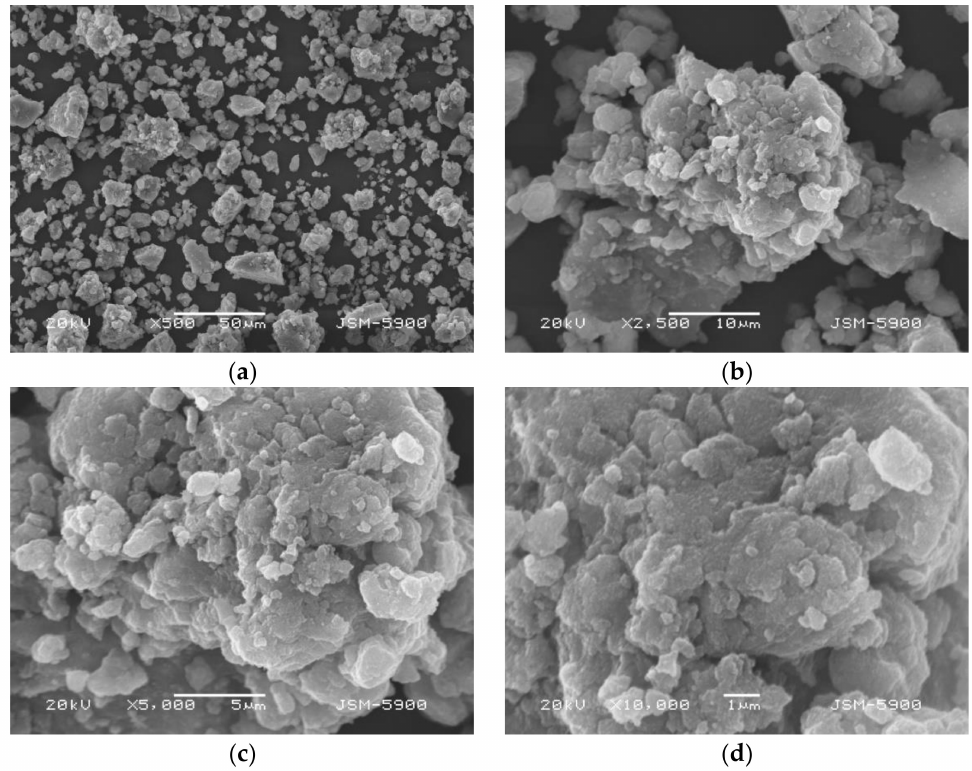
Figure 1. Micrographs captured by SEM at various magnifications (( a ) × 500, ( b ) × 2,500, ( c ) × 5000, and ( d ) × 10,000) of Mg-5Ni dehydrogenated at the eighth cycle. An X-ray diffractogram of Mg-5Ni dehydrogenated at the eighth cycle is shown in Figure 2. The sample contains Mg and small amounts of β -MgH 2 , Mg 2 Ni, and MgO. Mg 2 Ni is believed to have been formed during heating at the first cycle [12]. Mg and Mg 2 Ni absorb hydrogen and then release hydrogen during hydriding-dehydriding